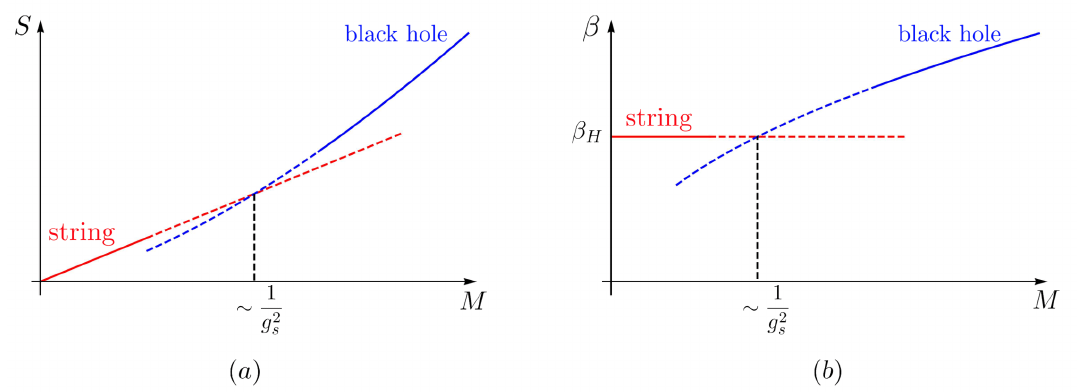
Figure 1 . (a) The entropy S as a function of mass M for both a free string and a black hole. The solid line describes the region where we can trust the computation and the dashed lines represent a naive (and incorrect) extrapolation. The extrapolated lines cross at roughly M ∝ 1 /g 2 can trust neither of the solutions. At this point the black hole also has a string scale temperature, and a string scale